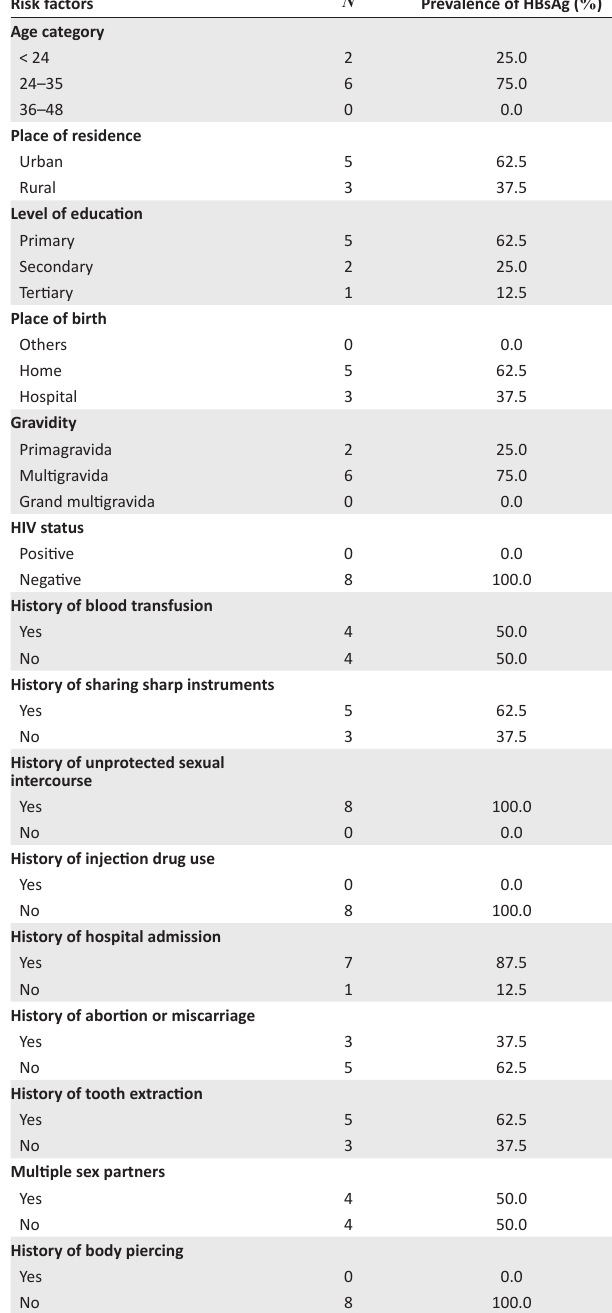
TABLE 3: Prevalence of HBV infection by risk factor among pregnant women attending Kyazanga Health Centre IV, South Western Uganda, between April 2021 and June